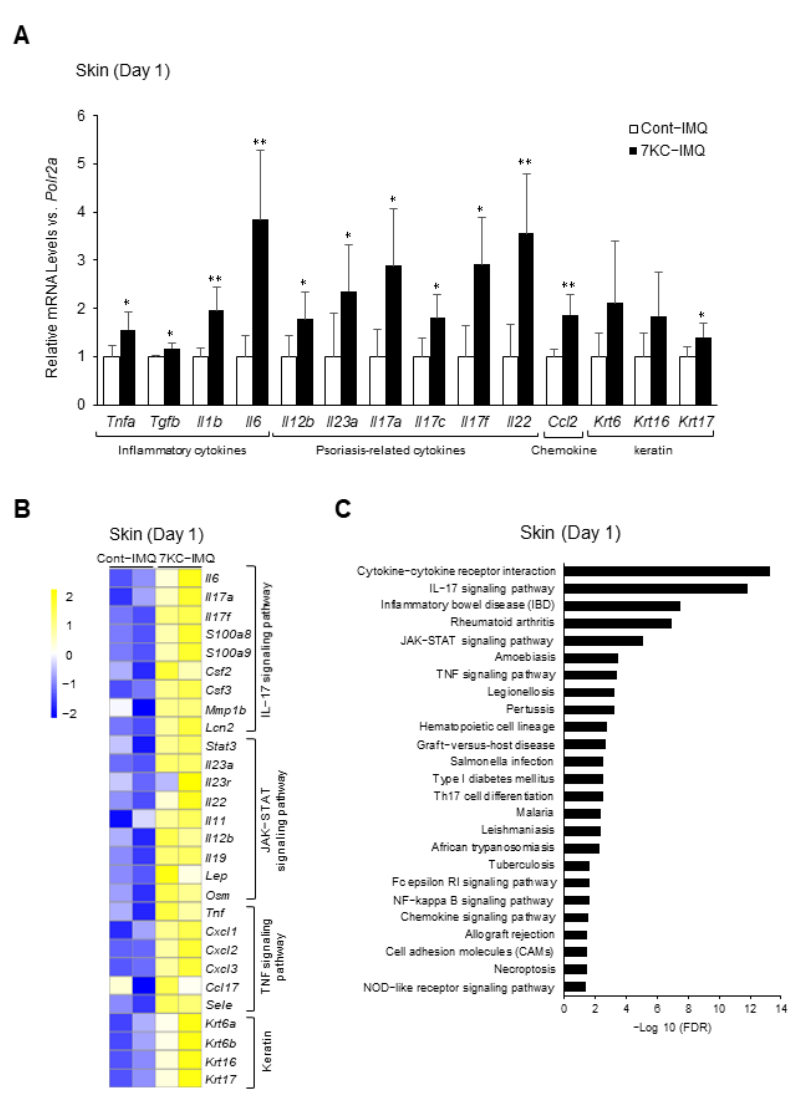
Figure 4. 7KC-induced steatohepatitis promoted the TNF- and IL-17 signaling pathways in the skin. Mice were fed a NASH diet or 7KC diet for three weeks, and then received imiquimod (IMQ) cream